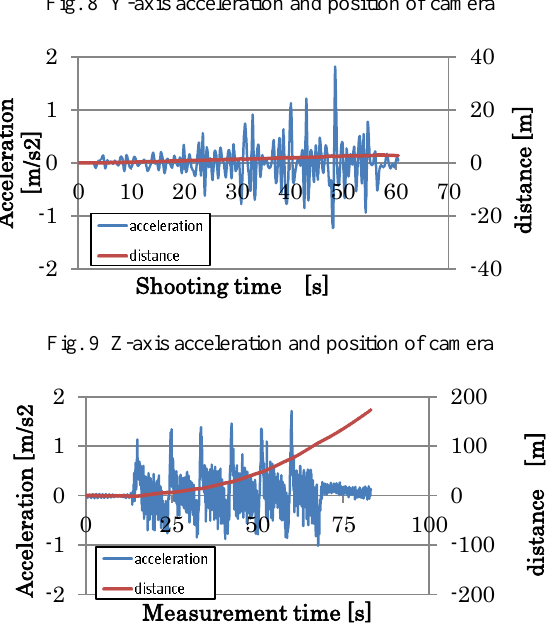
Fig. 8 Y-axis acceleration and position of camera